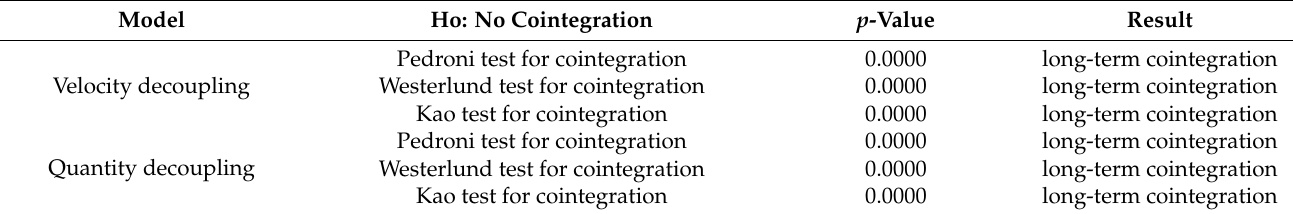
Table 4. Test of cointegration